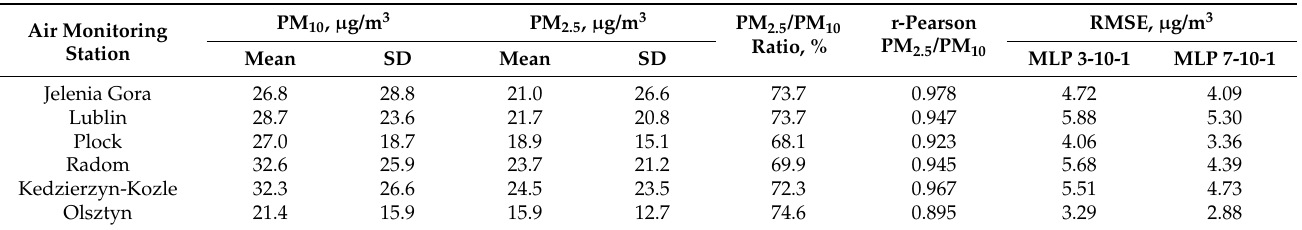
Table 8. Summary of modeling results: modeling errors and statistics on PM 2.5 and PM 10 concentra- tions for different air monitoring